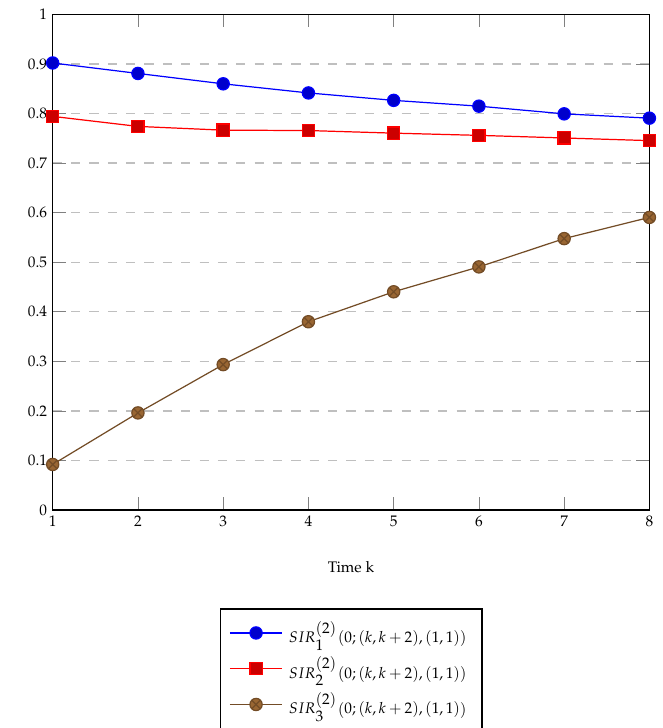
Figure 2. Sequential interval reliability plot with equally moving intervals